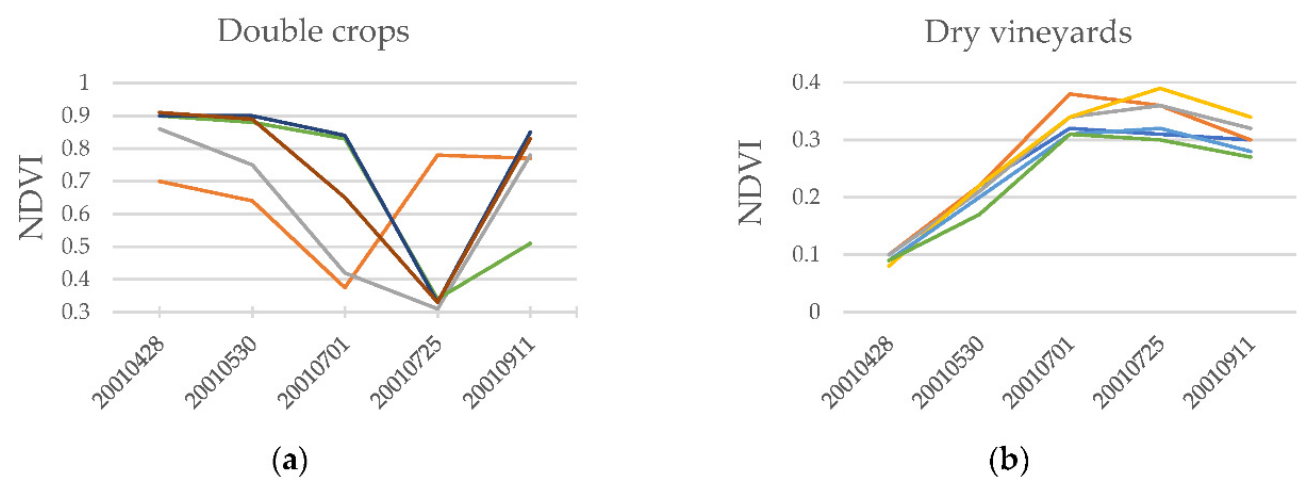
Figure 15. Rule 5 applied to irrigated herbaceous crops and vineyard crop polygons. Coloured lines depict the pixels selected as NDVI median values in polygons for ( a ) double crop filtered samples, and ( b ) dry vineyard woody crop field filtered samples.